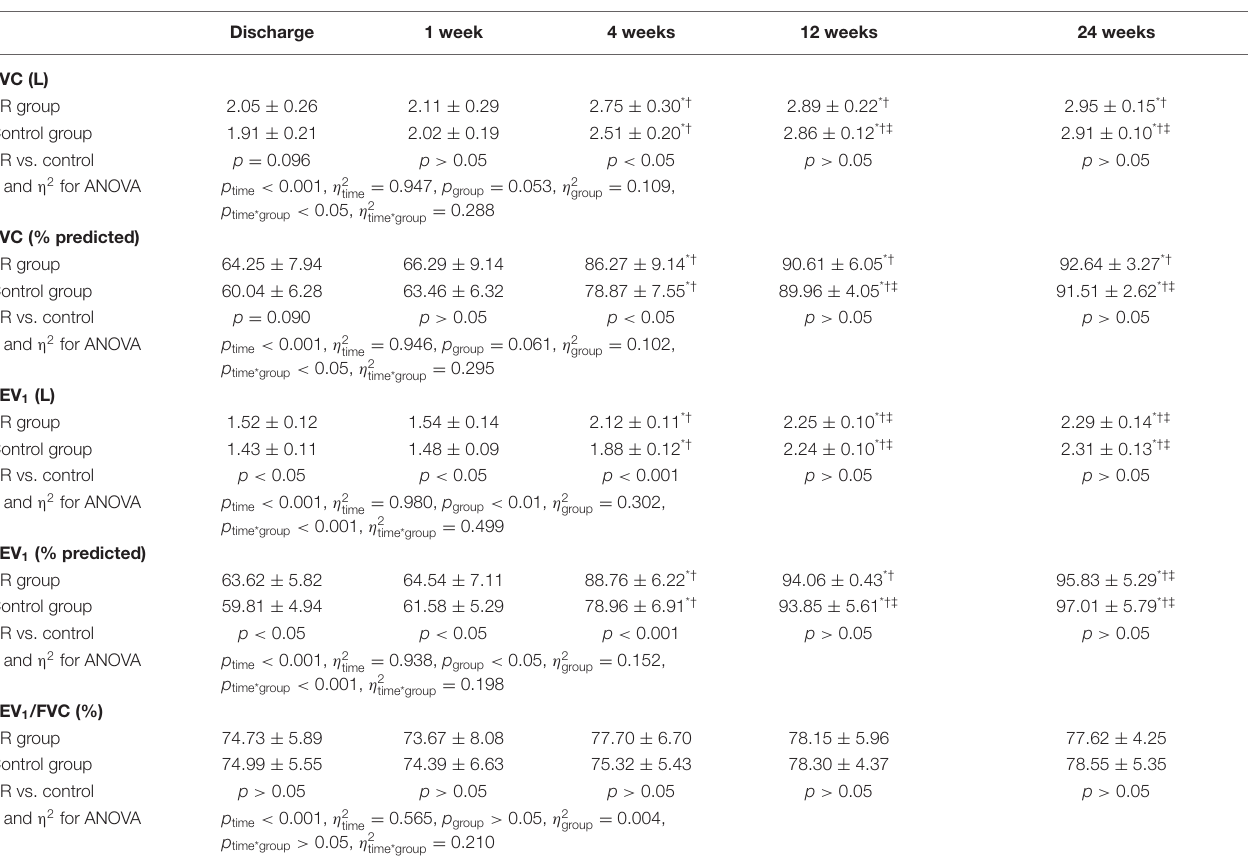
TABLE 5 | Forced vital capacity and forced expiratory volume in